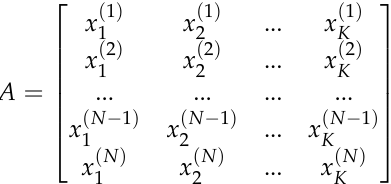
, ˆ σ i ) graphs, respectively—reporting the values of ˆ µ i , ˆ µ ∗ i